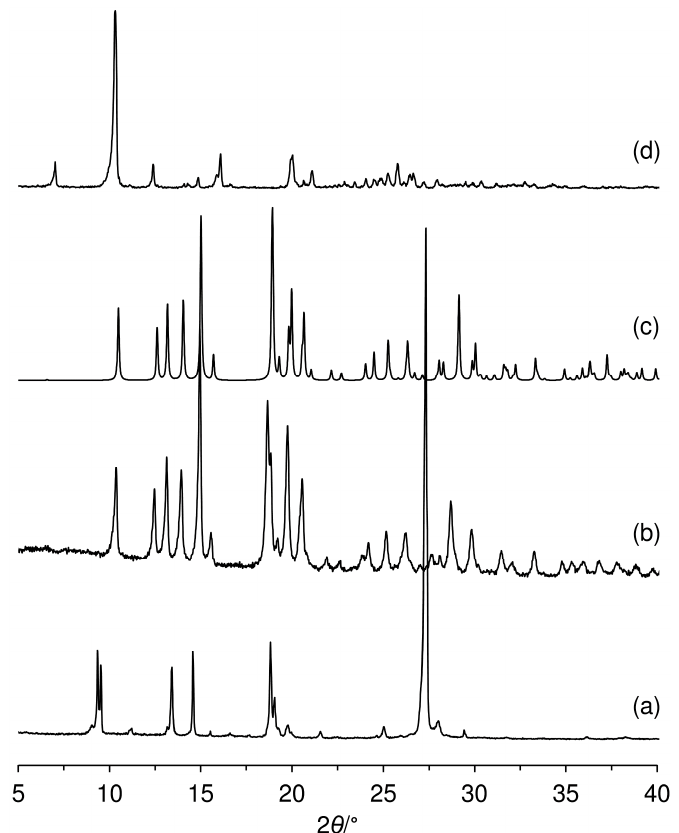
Figure 1. Experimental ( a , b , d ) and computed ( c ) powder X ‐ ray diffraction (PXRD) patterns of ( a ) 5 ‐ (2 ‐ pyridyl) ‐ 1 H ‐ tetrazole (Hpytz), ( b , c ) (H 2 pytz)[MoO 2 Cl 2 (pytz)] ( 1 ), and ( d ) [MoO 3 (Hpytz)] ( 2 ). The program Mercury (copyright CCDC, ver. 3.9) [44] was used to generate the computed pattern from the crystal structure for 1 .